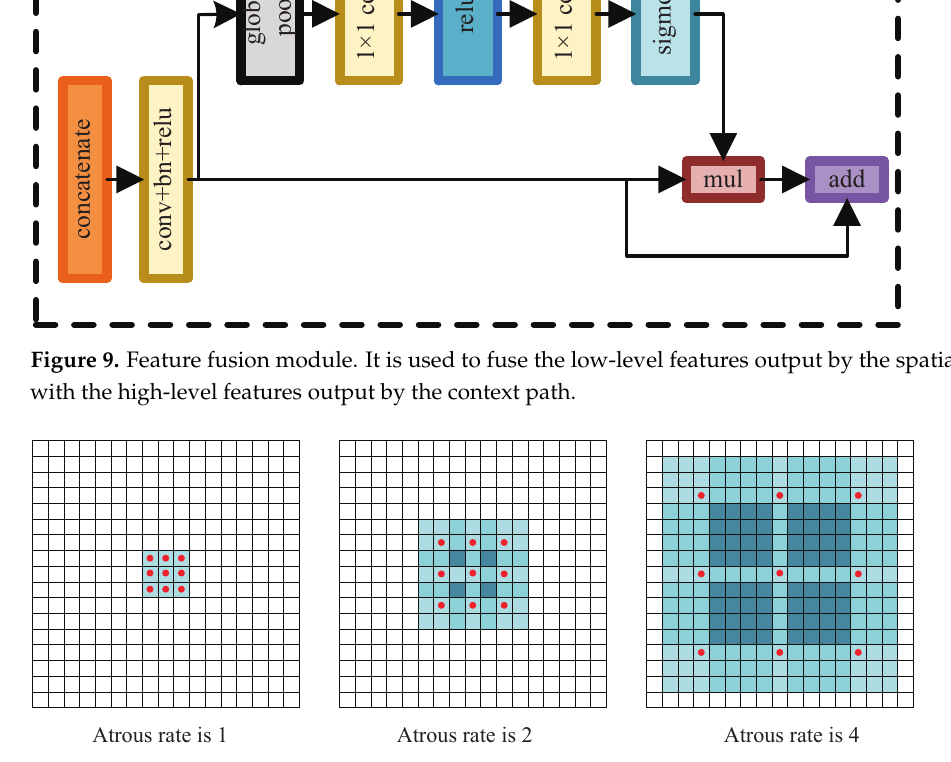
Figure 10. Atrous convolution. Increase the receptive field by injecting